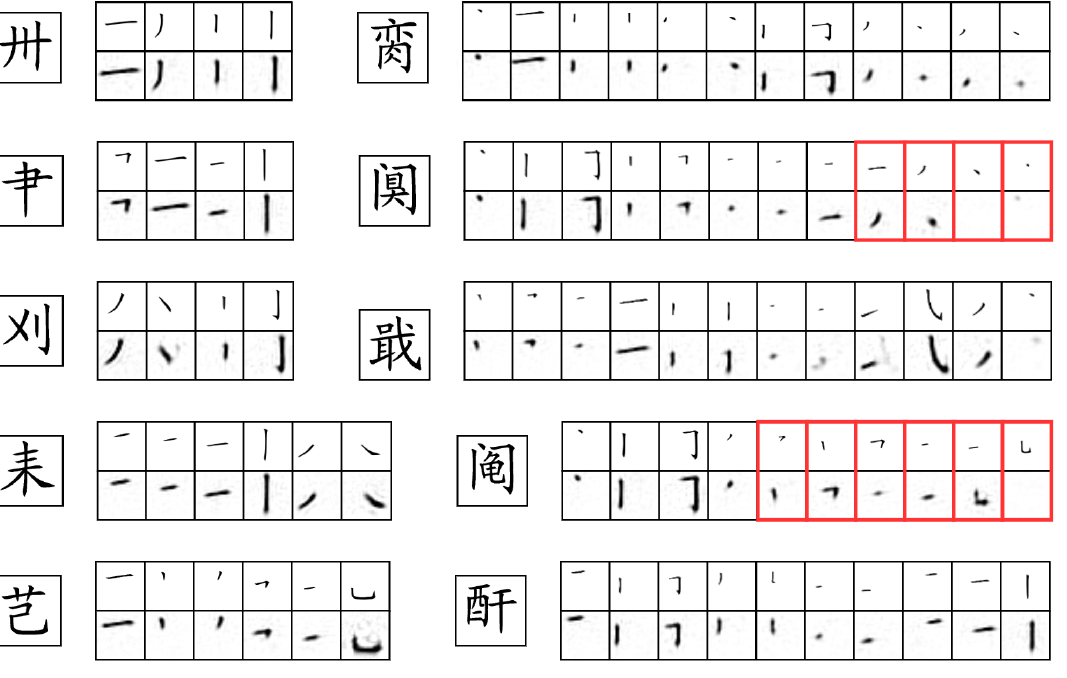
Figure 11. Example results on validation datasets of second form pre-trained on SAE based on Resnet and Transformer. Each character has the original picture (above) and reconstructed picture (below). Those enclosed in red boxes represent some wrong